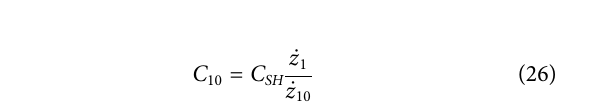
FIGURE 8 | Expected current of MR damper: (A) 2 Hz, (B) 4 Hz, (C) 6 Hz, and (D) 8 Hz.